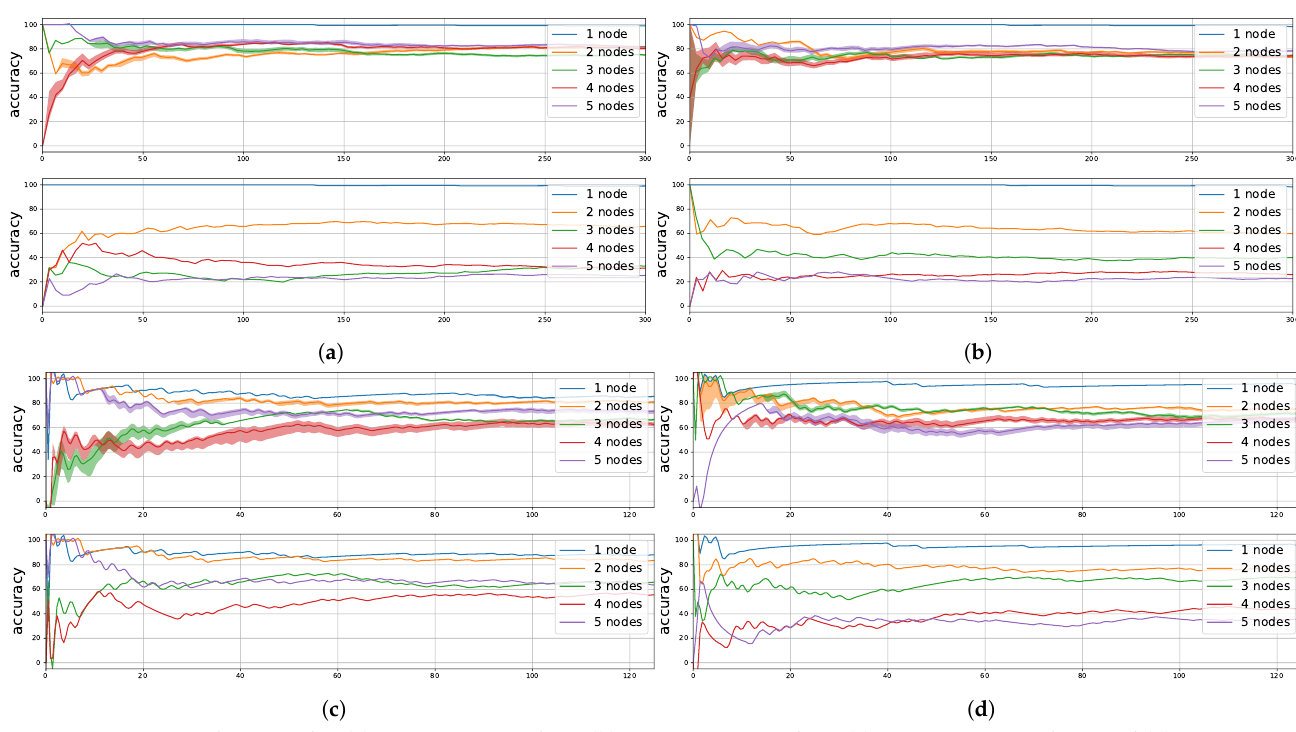
Figure 11. Simulator results: ( a ) SF = 7, P tx = 0 dBm, ( b ) SF = 7, P tx = 14 dBm, ( c ) SF = 12, P tx = 0 dBm, and ( d ) SF = 12, P tx = 14 dBm. Top: Random Forest results, bottom: Base model